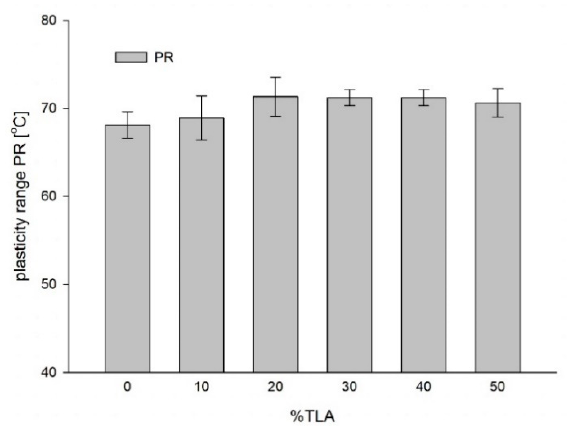
Figure 4. Plasticity range of TLA-modified binders.